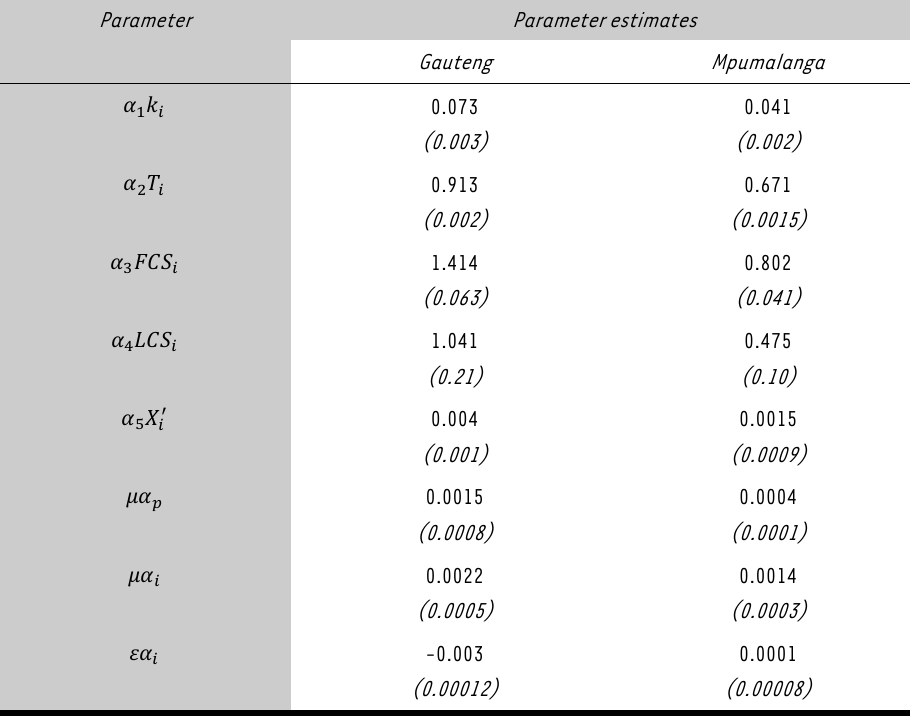
TABLE 1: Parameter estimates for the wage function of the category A employee segment